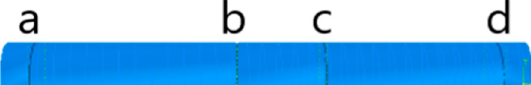
Figure 4. Thumb segmentation.